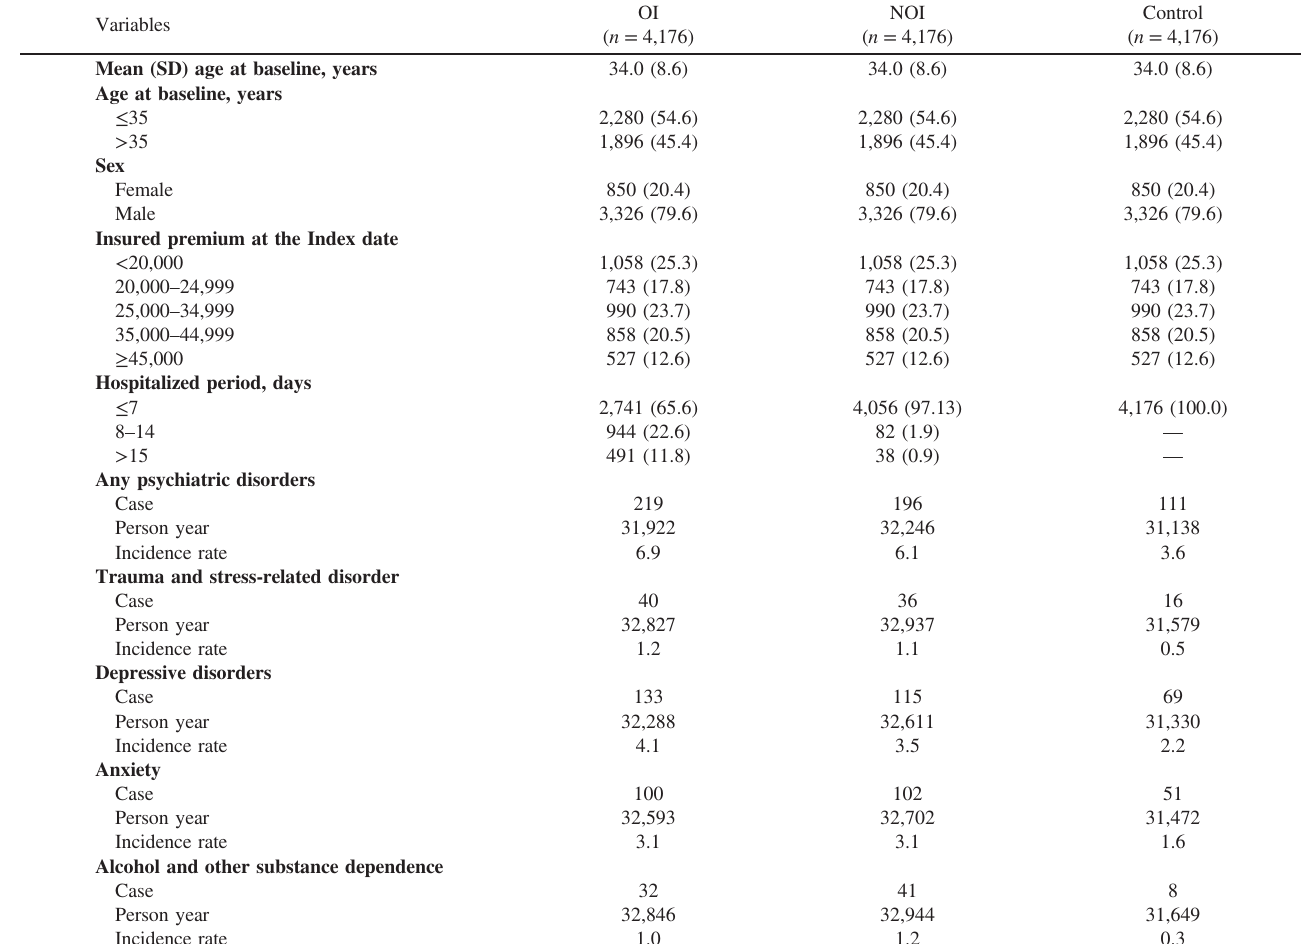
Table 1. Characteristic and psychiatric disorders of subjects in di ff erent study cohorts Variables